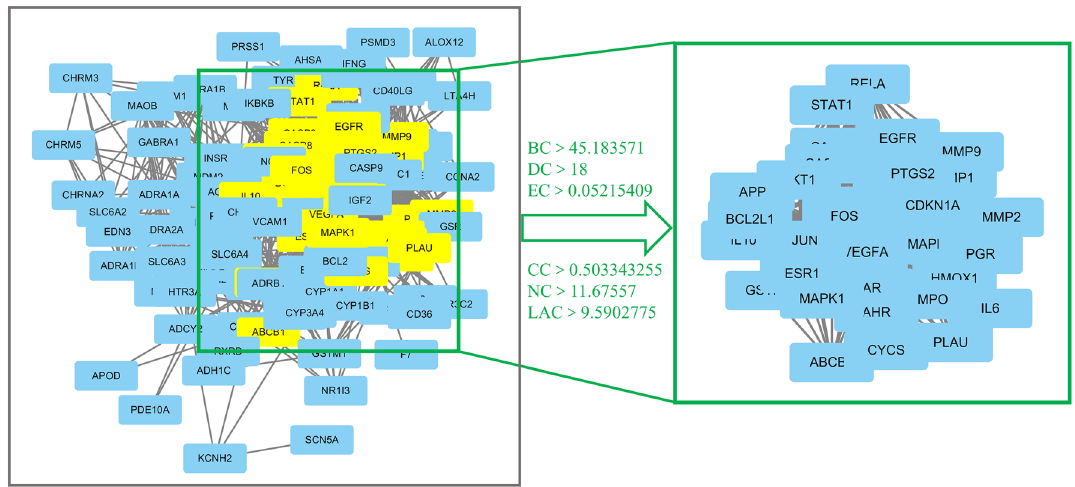
Figure 6. Identification of candidate targets for Banxia-Xiakucao Chinese Herb Pair in the treatment of sleep disorder. Flow chart of the screening process for the PPI network. Identification of candidate BXHP targets for sleep disorder treatment through the PPI network. Thirty-four core candidate BXHP targets with median topological feature values above the median were identified. BC, betweenness centrality; DC, degree centrality; EC, eigenvector centrality; CC, closeness centrality; NC, network centrality; LAC, local average